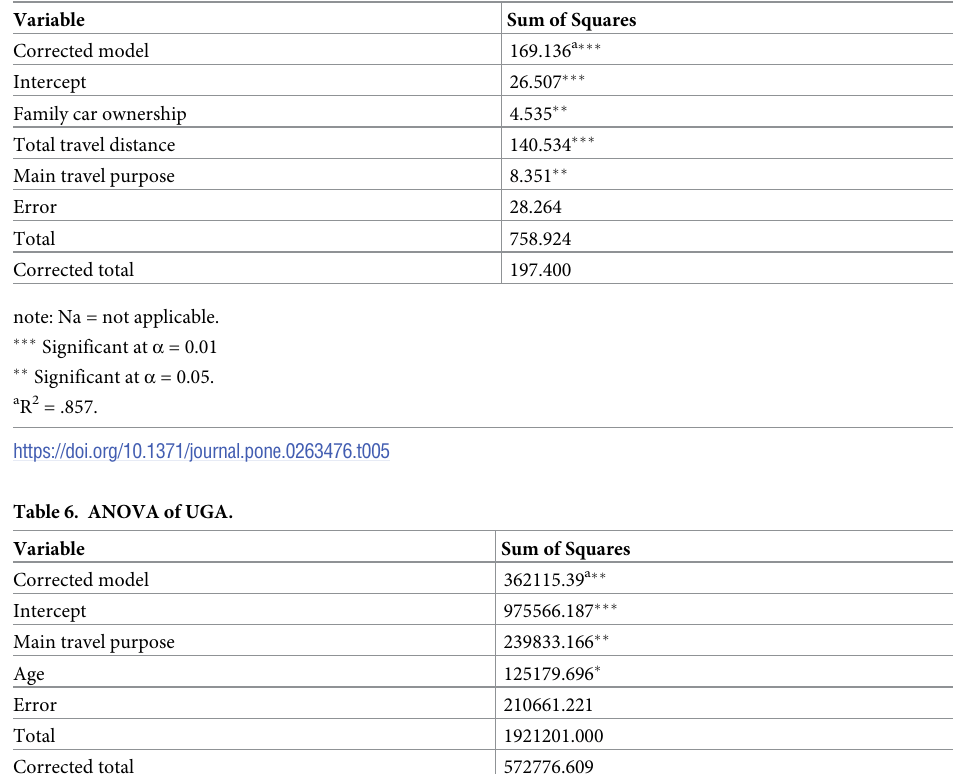
Table 5. ANOVA of UGB.